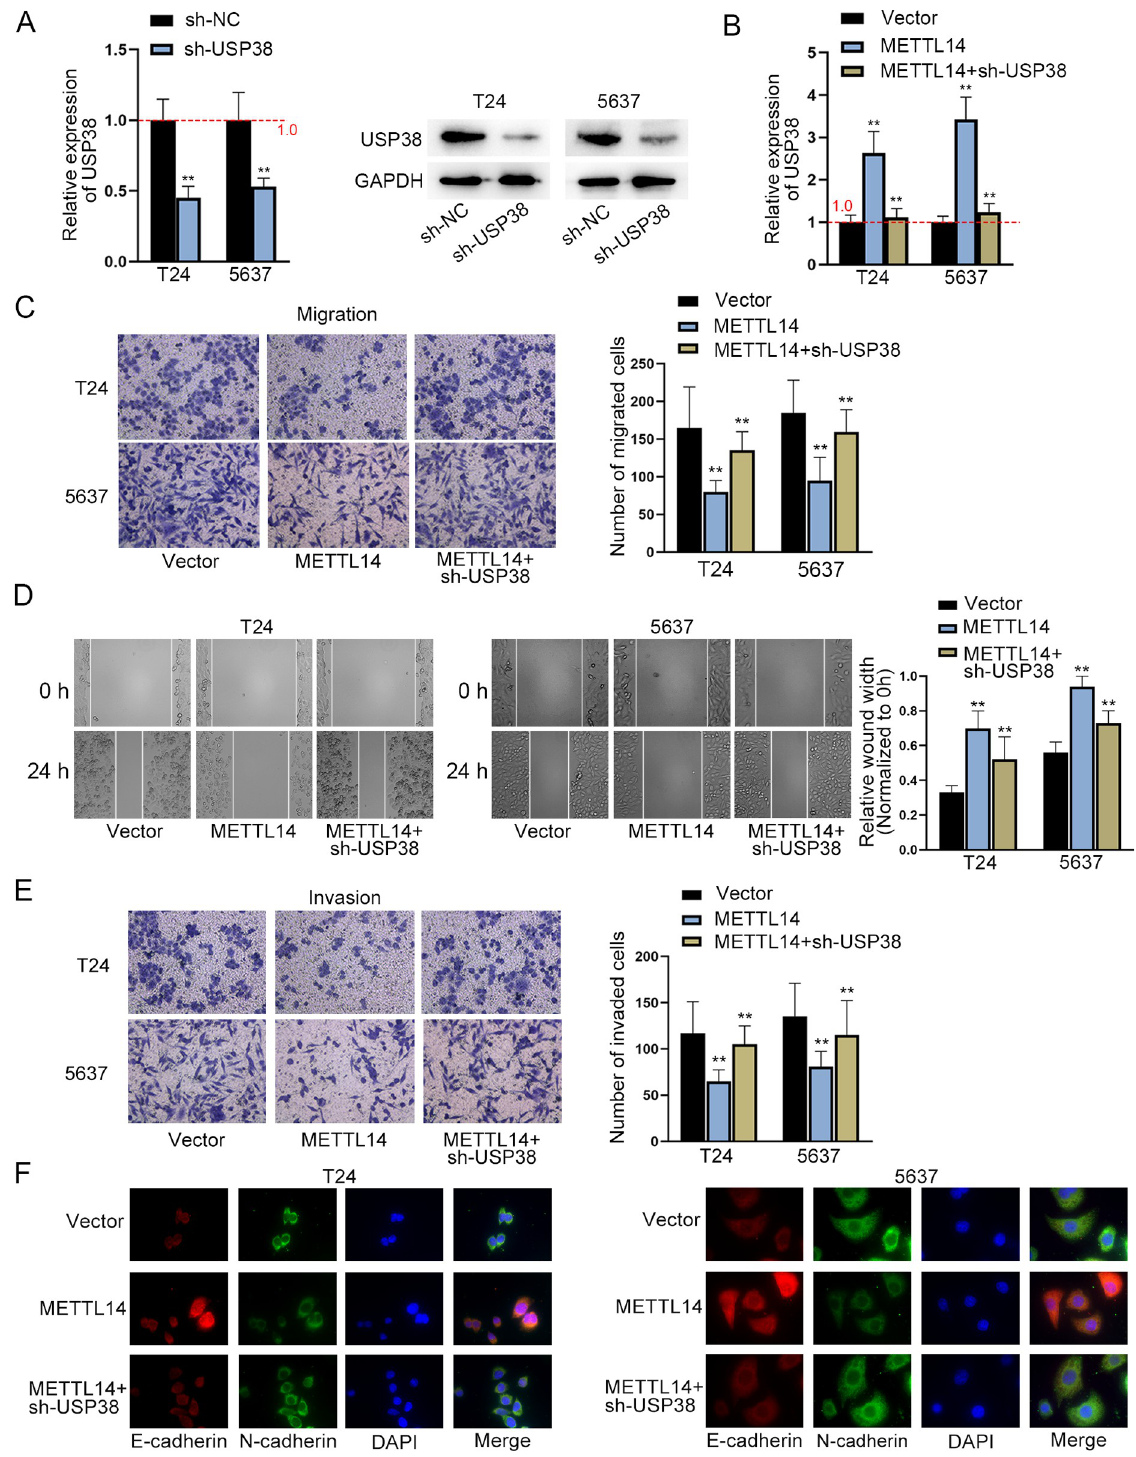
Fig 4. METTL14 promotes BCa cell migration, invasion and EMT by mediating USP38. A. RT-qPCR was used to evaluate the knockdown efficiency of sh-USP38 (left panel). (n = 3) Each bar represents mean; error bars represent SD. P values were determined by Student’s t test. Western blot of USP38 protein level in USP38-silenced cells was shown (right panels). B. RT-qPCR was used to evaluate the relative expression of sh-USP38 after the indicated transfection. (n = 3) Each bar represents mean; error bars represent SD. P values were determined by one-way ANOVA followed by Dunnett’s test. C-D. Transwell (migration) and wound healing assays were conducted to measure the